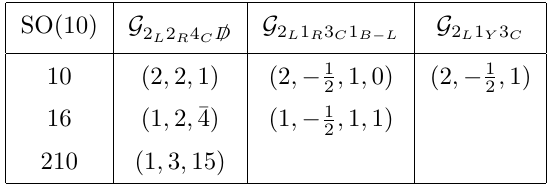
Table 1. Higgs representations that contribute to the RGEs at each stage of the symmetry breaking for the SO(10) model in section